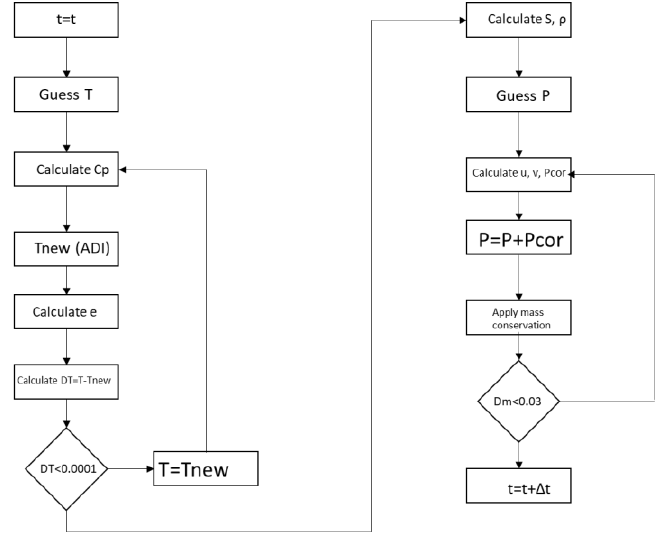
Figure 2. Flow diagram of the numerical scheme.